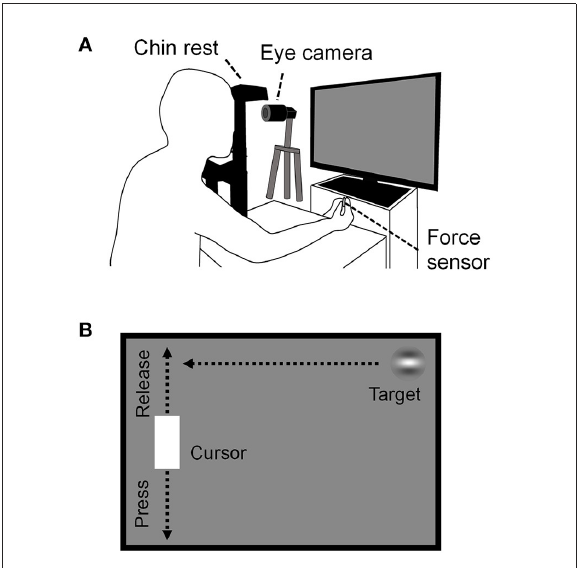
FIGURE2 Schema of the CVM task. (A) The experimental configuration is the same as in Figure 1, except that the participants prehend the force sensor with the thumb and index finger of the dominant hand. Left eye movements during the task were recorded using a USB camera. (B) Outline of the CVM Task. The target moved in a constant speed horizontally. The cursor moved in the Y-axis direction only, and its position corresponded to the magnitude of the prehensile force given to the force